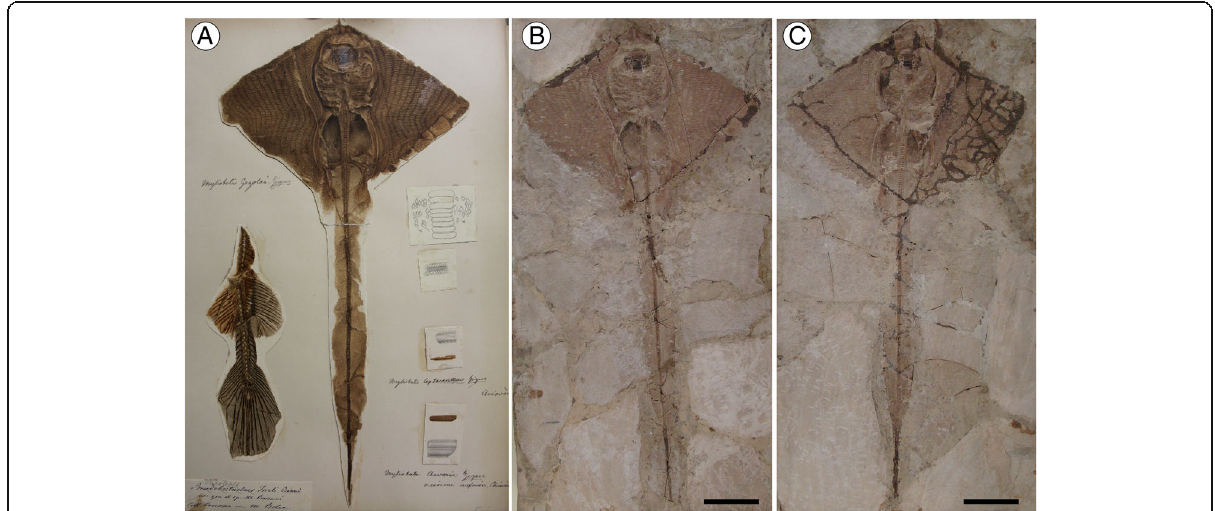
Fig. 1 Promyliobatis gazolai from the Eocene of the Bolca Lagerstätte. a Original historical plate of the holotype, illustrated and specified as Myliobates gazolai in de Zigno [23] and in de Zigno [49]; photo: courtesy of Università degli Studi di Padova. b , c MCSNV VII.B.90/91, holotype, in part and counterpart. Scale bars = 50